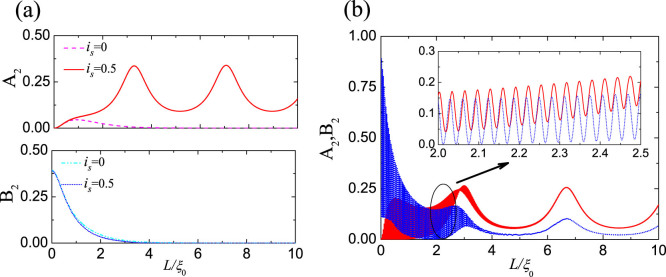
The probabilities of CAR and EC as functions of L for (a) Z2 = 0 and (b) Z2 = 0.8.The relevant parameters are set as Z1 = 1.25, E/Δ = 0.8, kF = 100/ξ0.